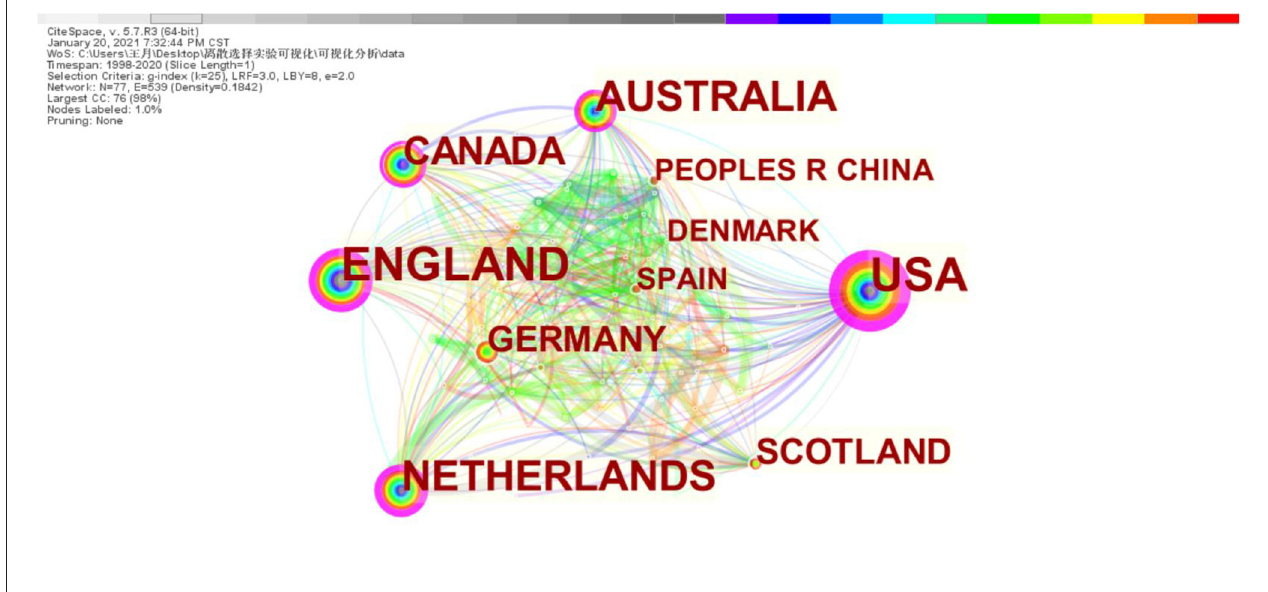
FIGURE 4 | Countries’ collaboration network.